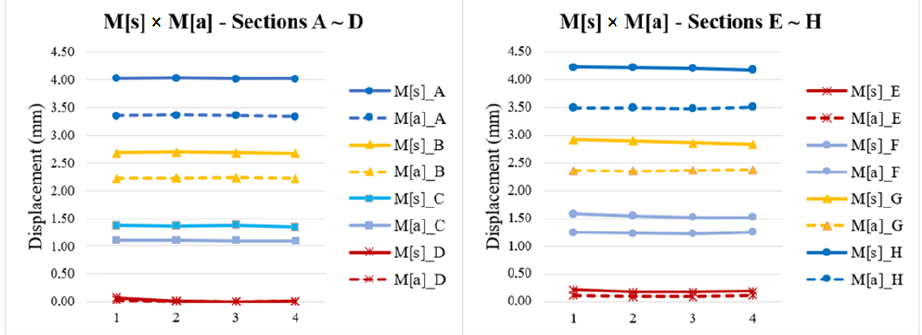
Figure 11. M[s] × M[a] Scatter plot — Sections A – H.